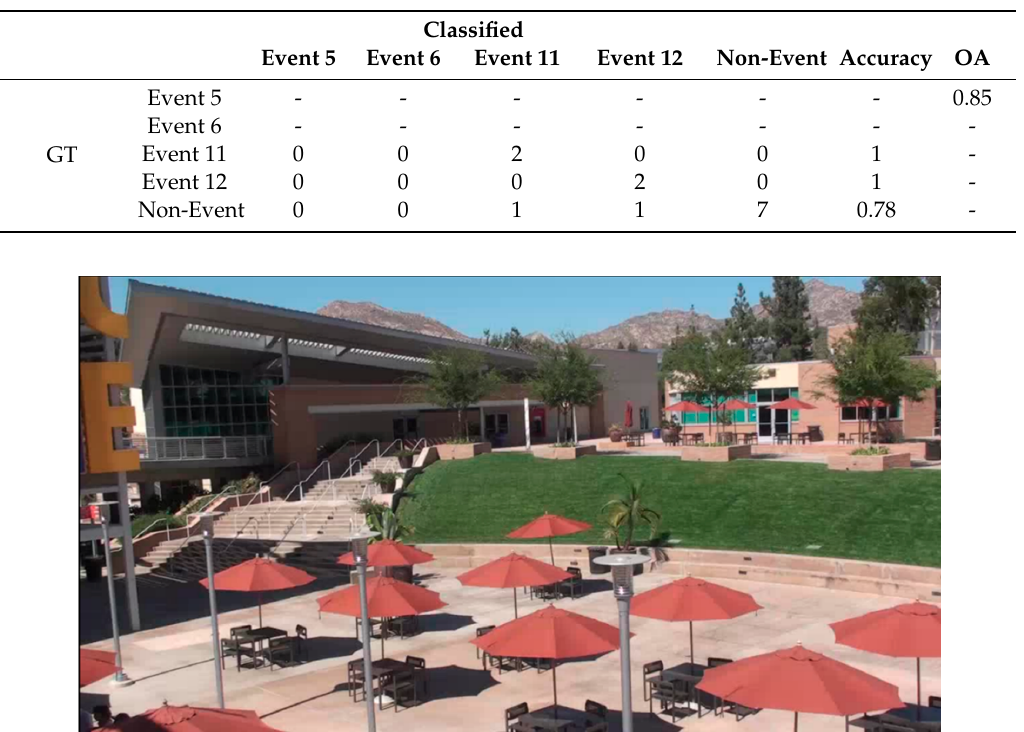
Figure 5. VIRAT_S_010000_04_000530_000605 Scene. This building scene has a lot of human activity. Table 5 . Event classification using the VideoGraph only approach for one VIRAT video: